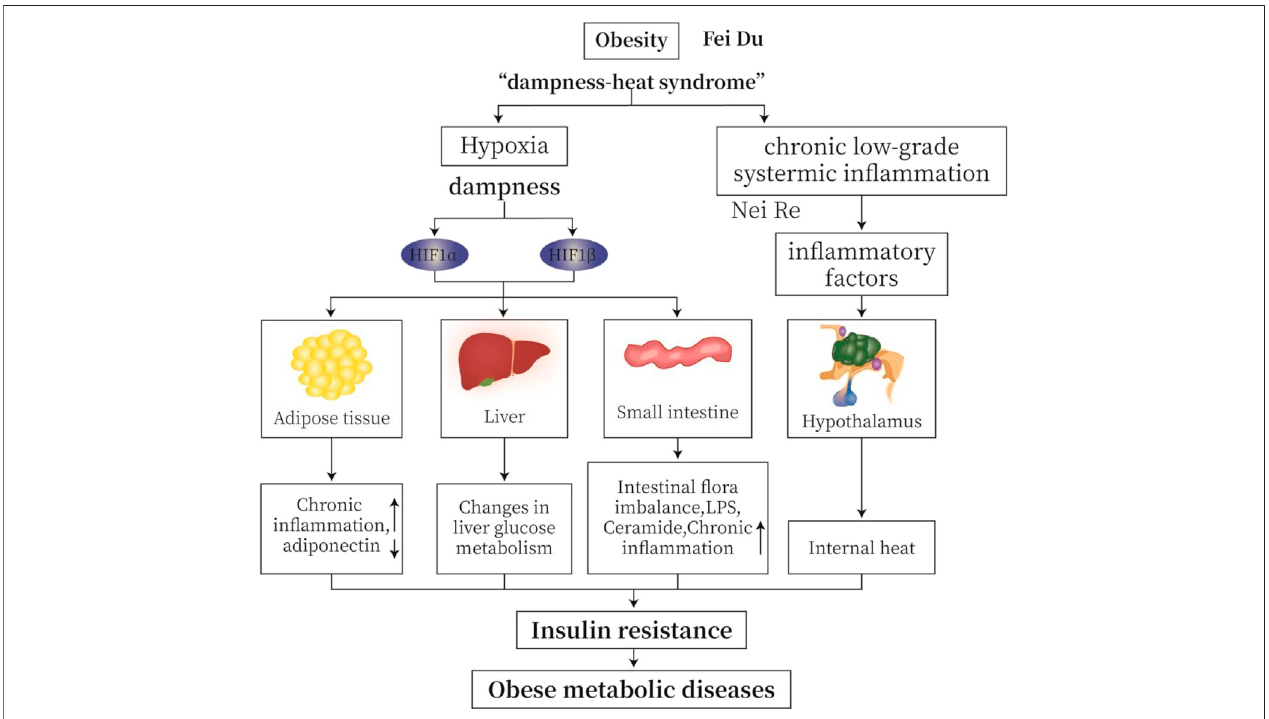
FIGURE 1 | TCM (traditional Chinese medicine) “ dampness-heat syndrome ” and MWM (modern western medicine) obesity with hypoxia and in fl ammation. “ Dampness ” causes intracellular and extracellular hypoxia in adipose tissue and small intestine. Hypoxia is an important feature of “ dampness syndrome ” . Chronic low-gradein fl ammationiscommoninobesepatients.FromMWManalysis,in fl ammation maycausetemperatureor “ heat ” .HypoxiainducestheproductionofHIFs, leading to increased production of in fl ammatory factors, decreased secretion of adiponectin, altered glucose metabolism, imbalanced intestinal fl ora, and increased lipopolysaccharide (LPS). All these changes cause insulin resistance (IR), and ultimately obese metabolic diseases.